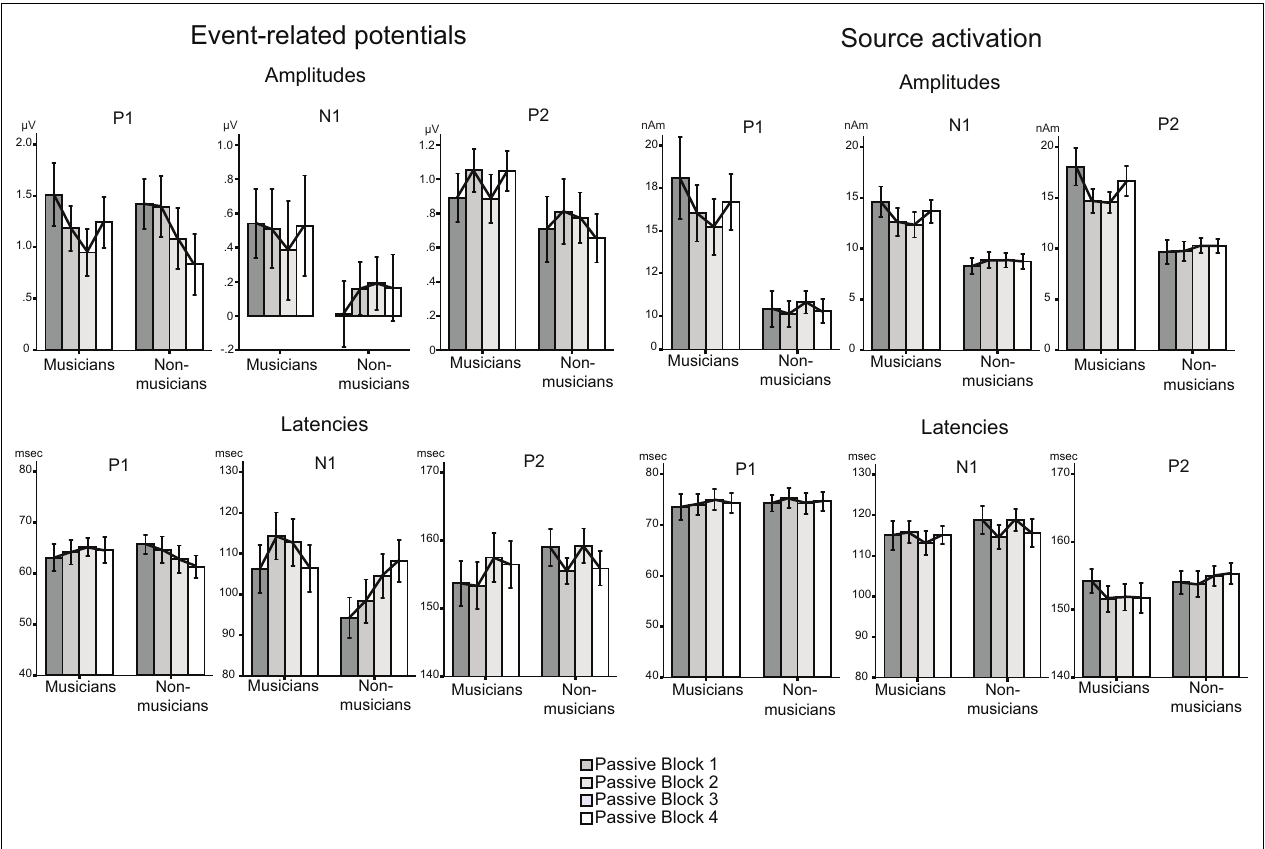
FIGURE 5 | Summary of the P1, N1, and P2 results (with SEs of the means) for amplitudes (left) and latencies (right) of standard sounds.